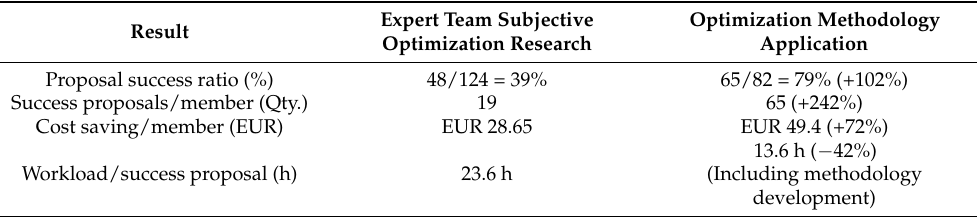
Table 13. Results comparison between methodology and experts’ team subjective